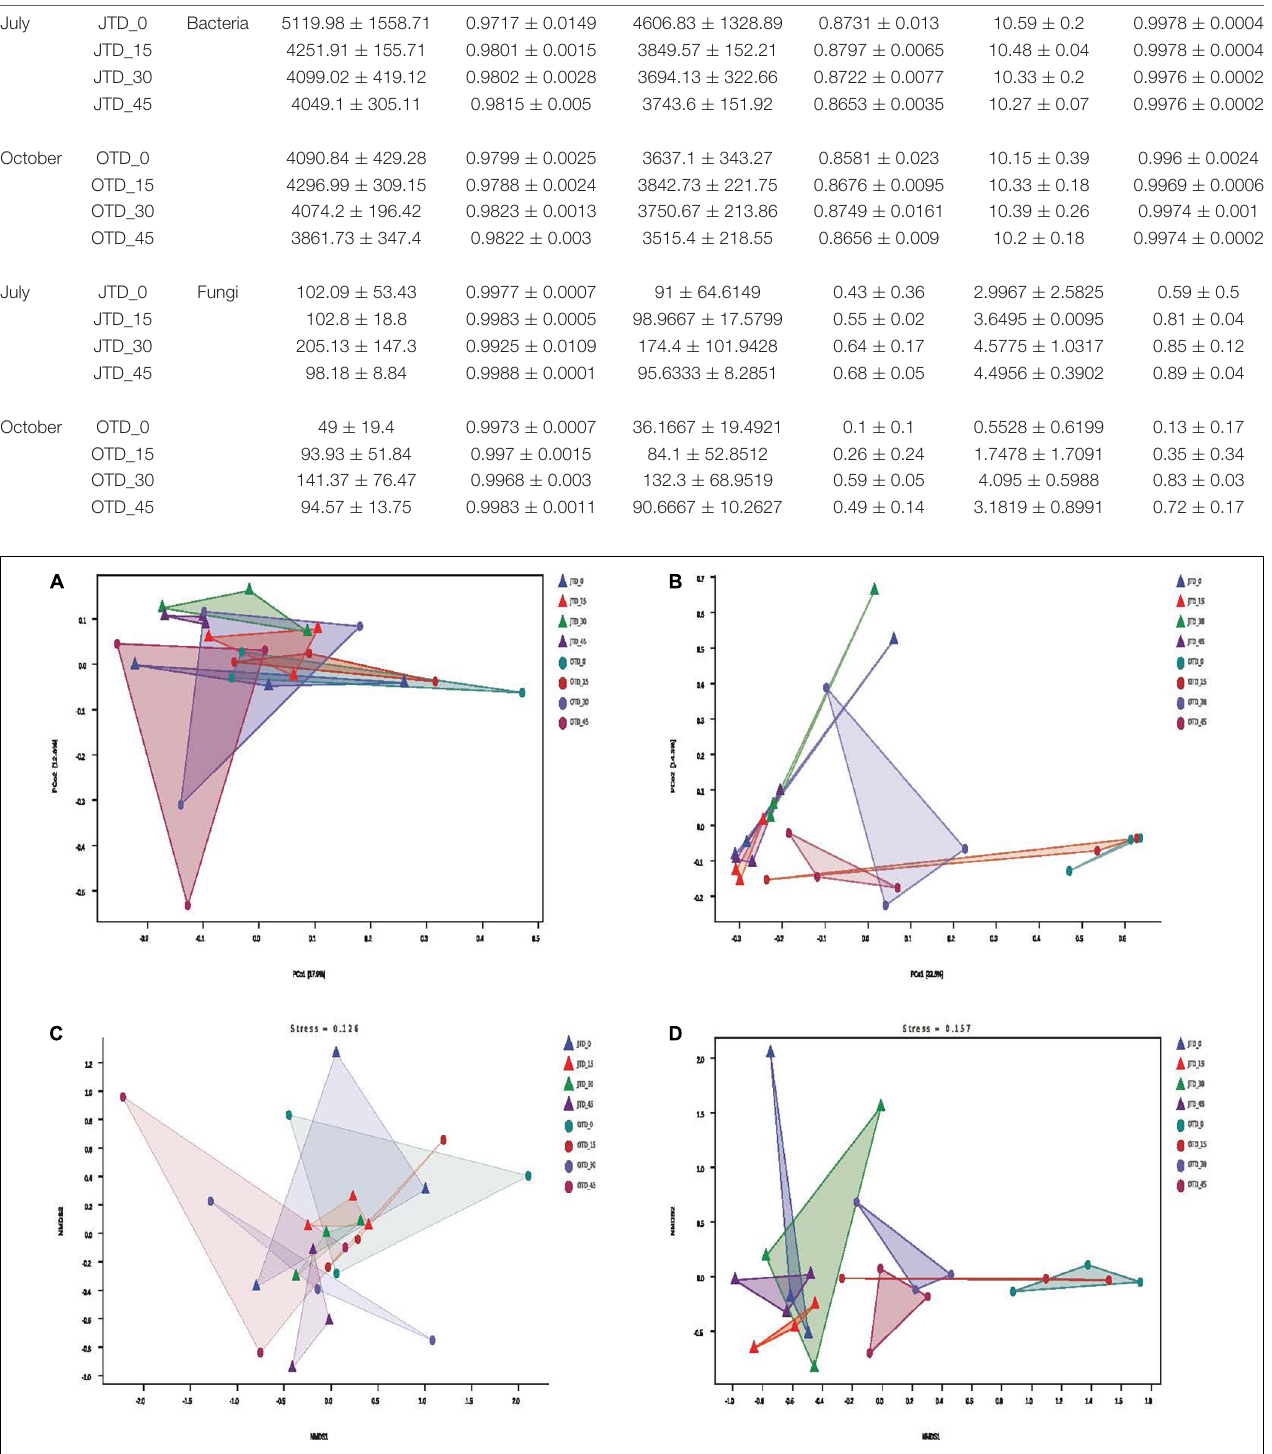
FIGURE 2 | Effect of different protein content diets on soil bacterial community composition. Principal coordinate analysis (PCoA) of soil bacterial (A) and fungal (B) communities using weighted UniFrac distance metrics. Non-metric multidimensional scaling (NMDS) ordination plot of soil bacterial (C) and fungal (D) communities based on the number of OTUs detected by